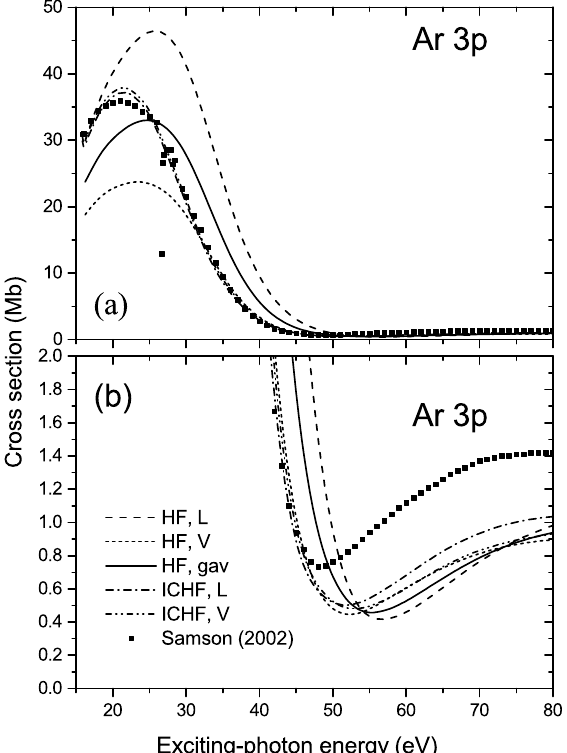
Figure 3. Total experimental PICS of Ar [23] (Samson 2002) and presently computed PICS of the Ar 3p shell in the single-electron HF approximation in length geometric average between the length and velocity forms into account intra-shell correlation(s) (ICHF) in length and velocity forms are depicted as well. Panel ( b ) represents an enlarged part of panel ( a ) in the region of the Cooper